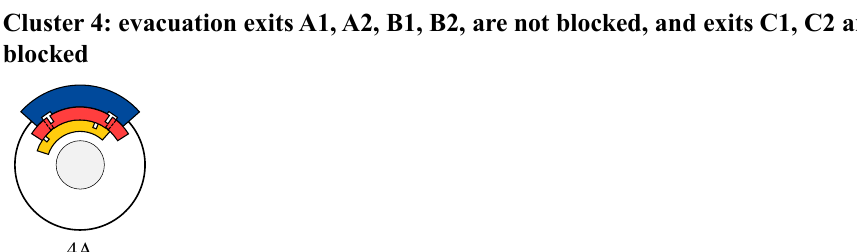
Figure 9. Typical layouts of the rotating auditorium for Clusters 1 to 4.